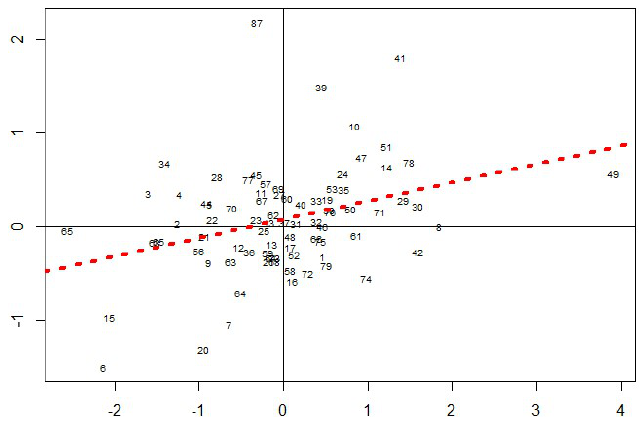
Figure 10. Moran Scatter Plot of per capita GDP growth rates for